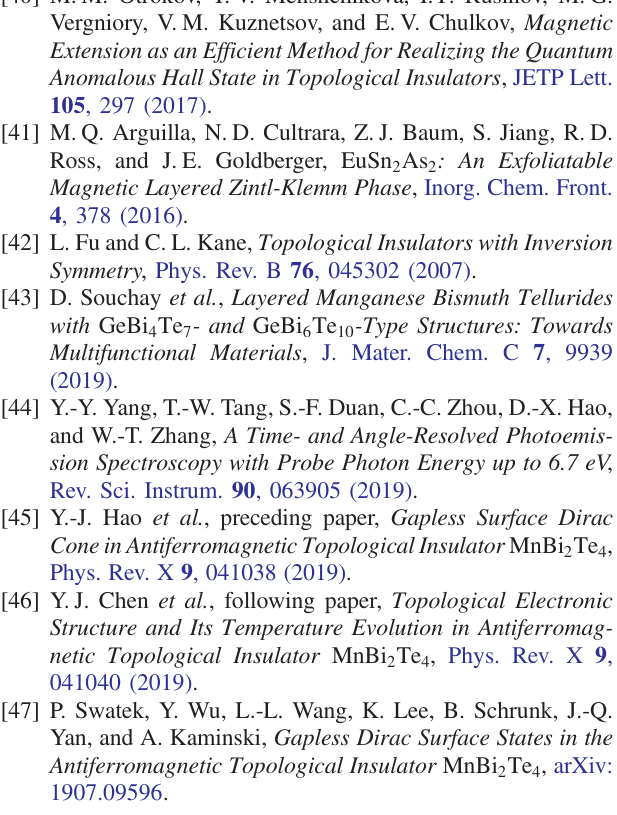
Correction: Section headings in the middle of the paper were missing and have been